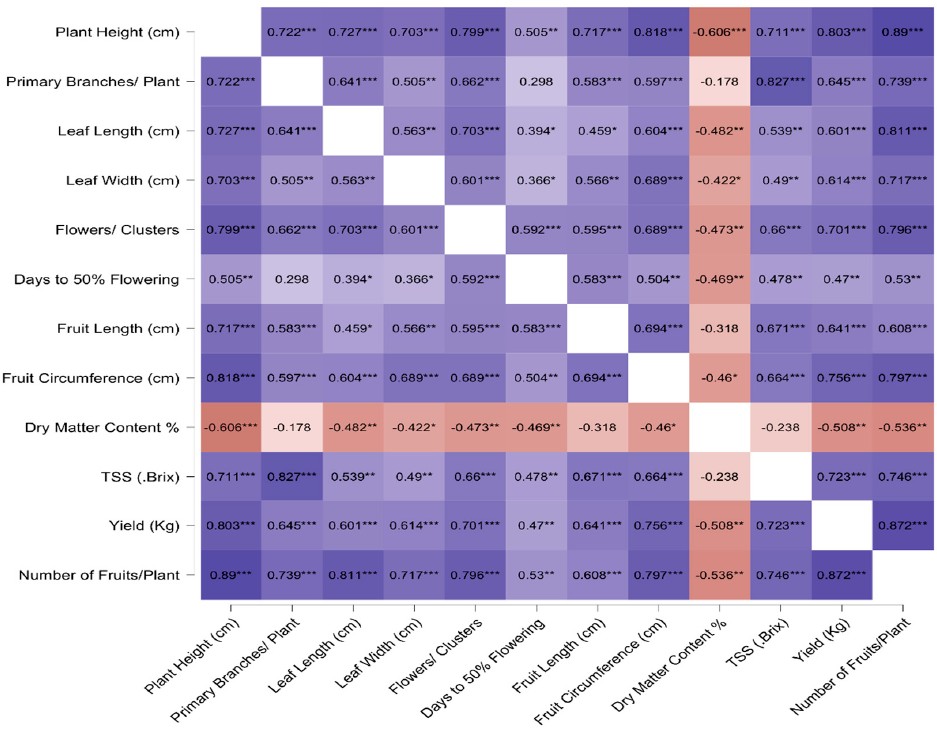
Figure 1. Pearson linear correlations of the studied parameters. Where, ***, **, * indicate significant at p < 0.001, p < 0.01, or p < 0.05, respectively.